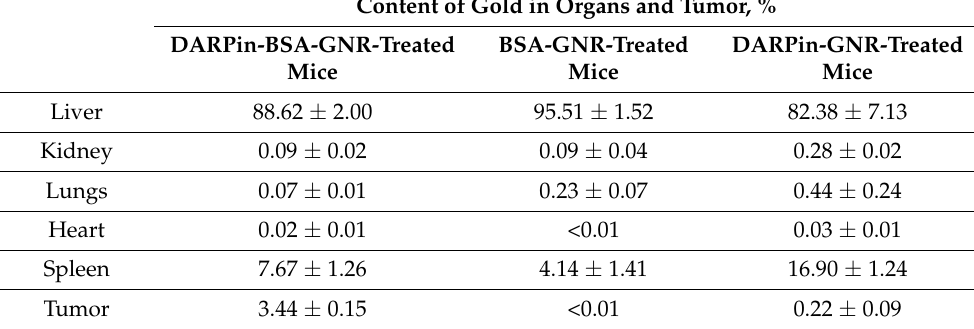
Table 1. Distribution of gold in organs of tumor-bearing mice. Content of Gold in Organs and Tumor, % DARPin-BSA-GNR-Treated BSA-GNR-Treated DARPin-GNR-Treated Mice Mice Mice Liver 88.62 ±